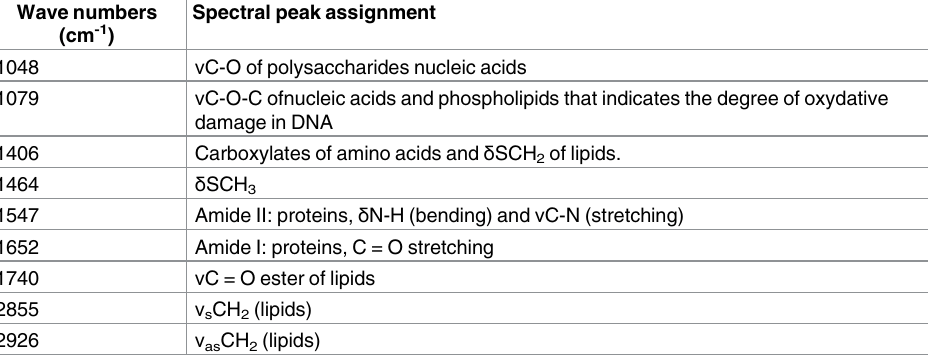
Table 1. Spectral peak